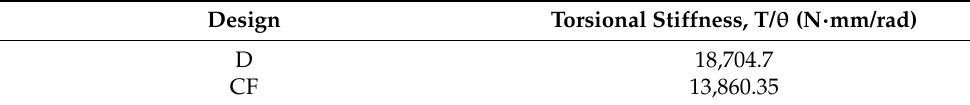
Table 5. Torsional stiffness values of D and CF structures.